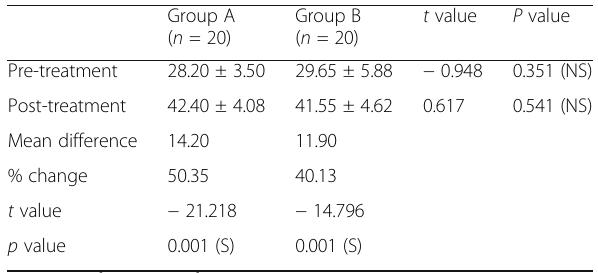
Table 5 Comparison of mean values of extension of lumber spine within and between both groups